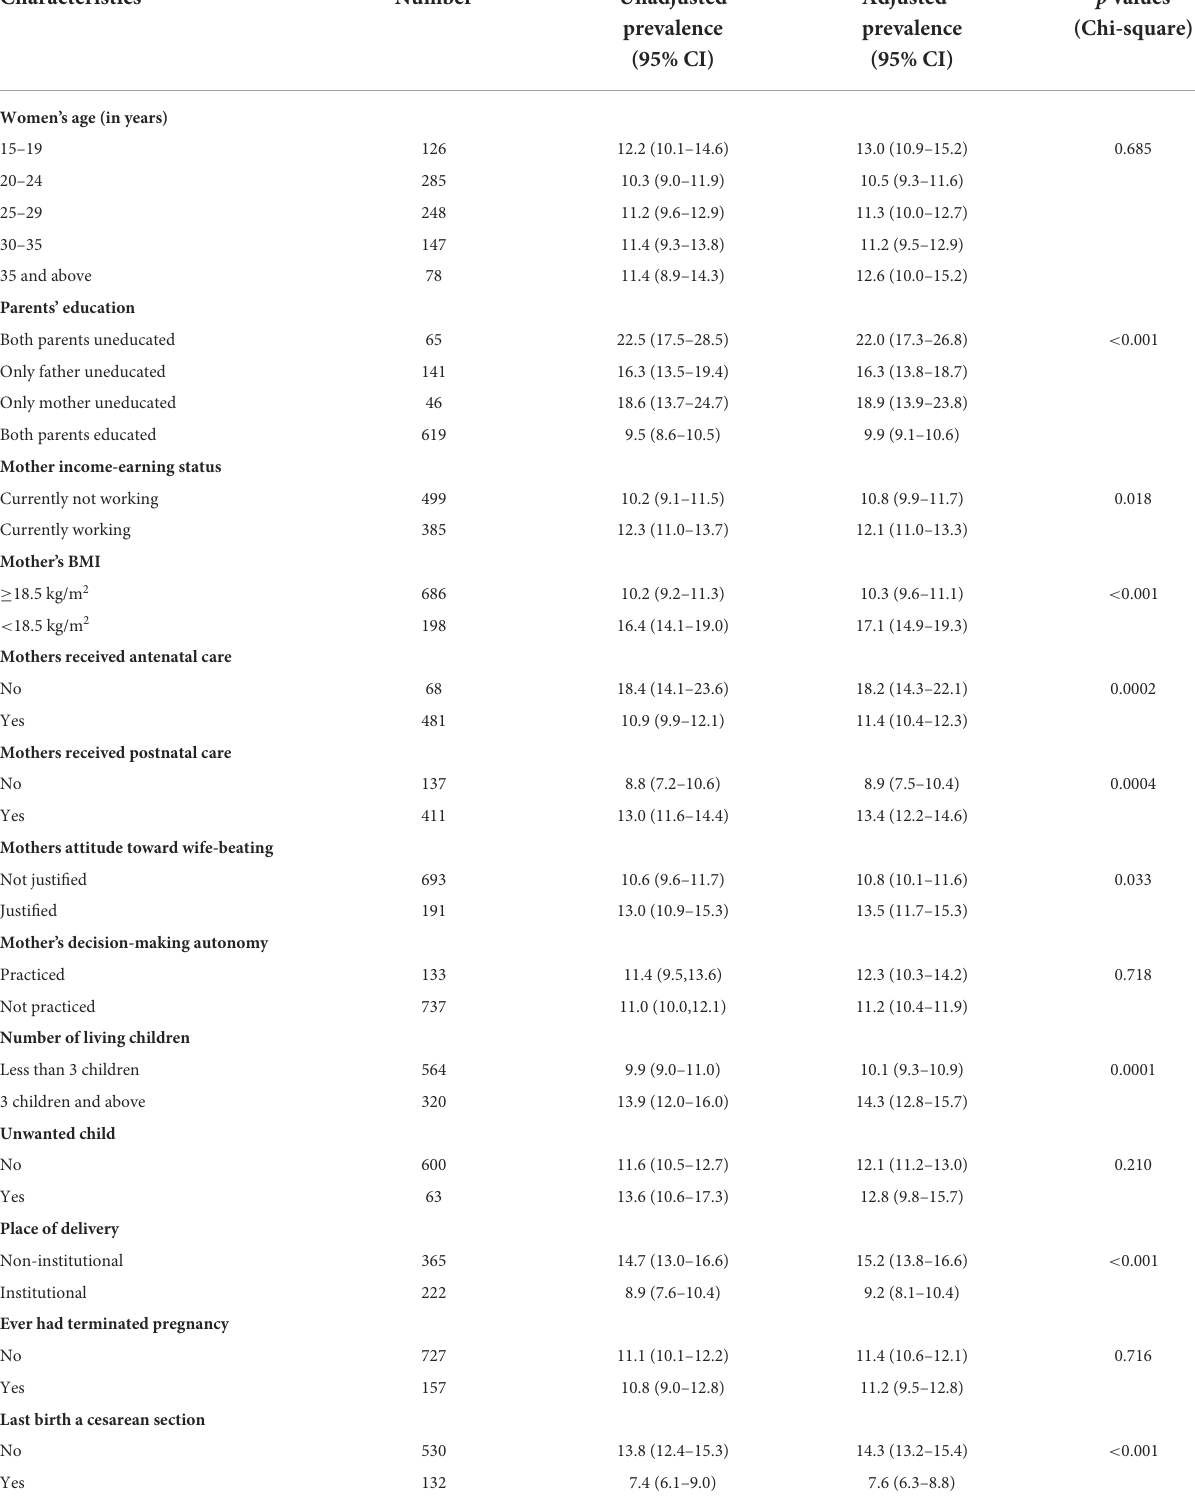
TABLE 3 Prevalence of SAF based on the CISAF among children under-5.